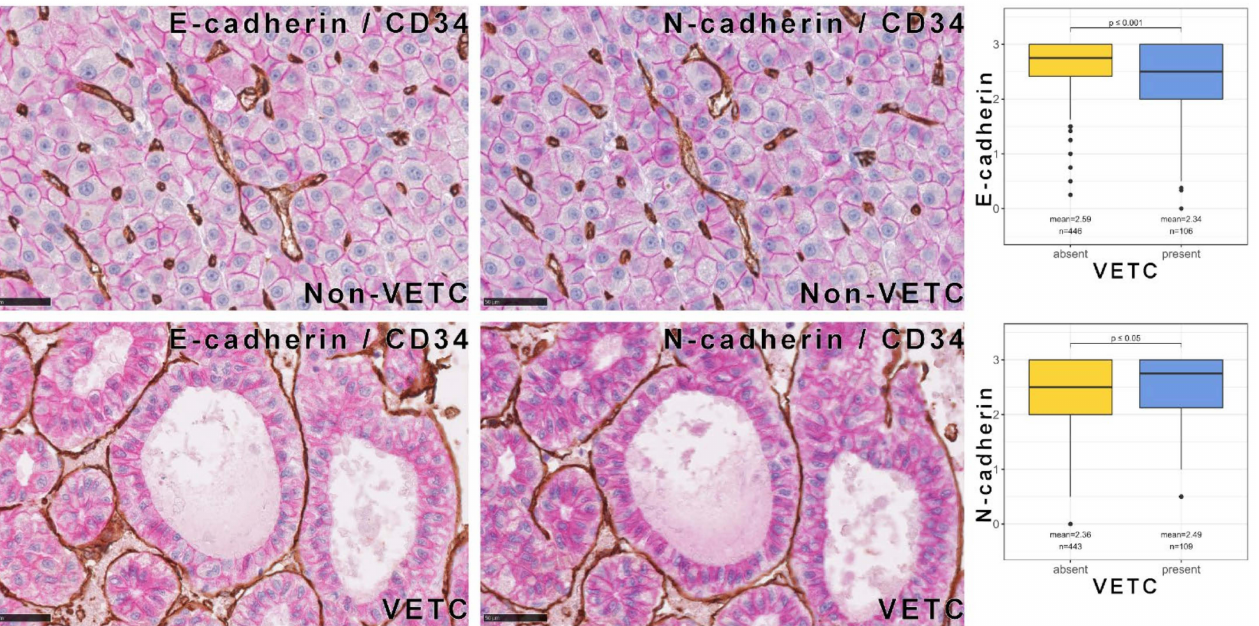
Figure 6. Association between E- and N-cadherin expression and VETC pattern in HCC. Double- labeling immunohistochemistry of CD34-expressing vessels (brown) with E- and N-cadherin (red). The differences are very small in individual cases and are only evident in the statistical analysis of the very large cohort (right